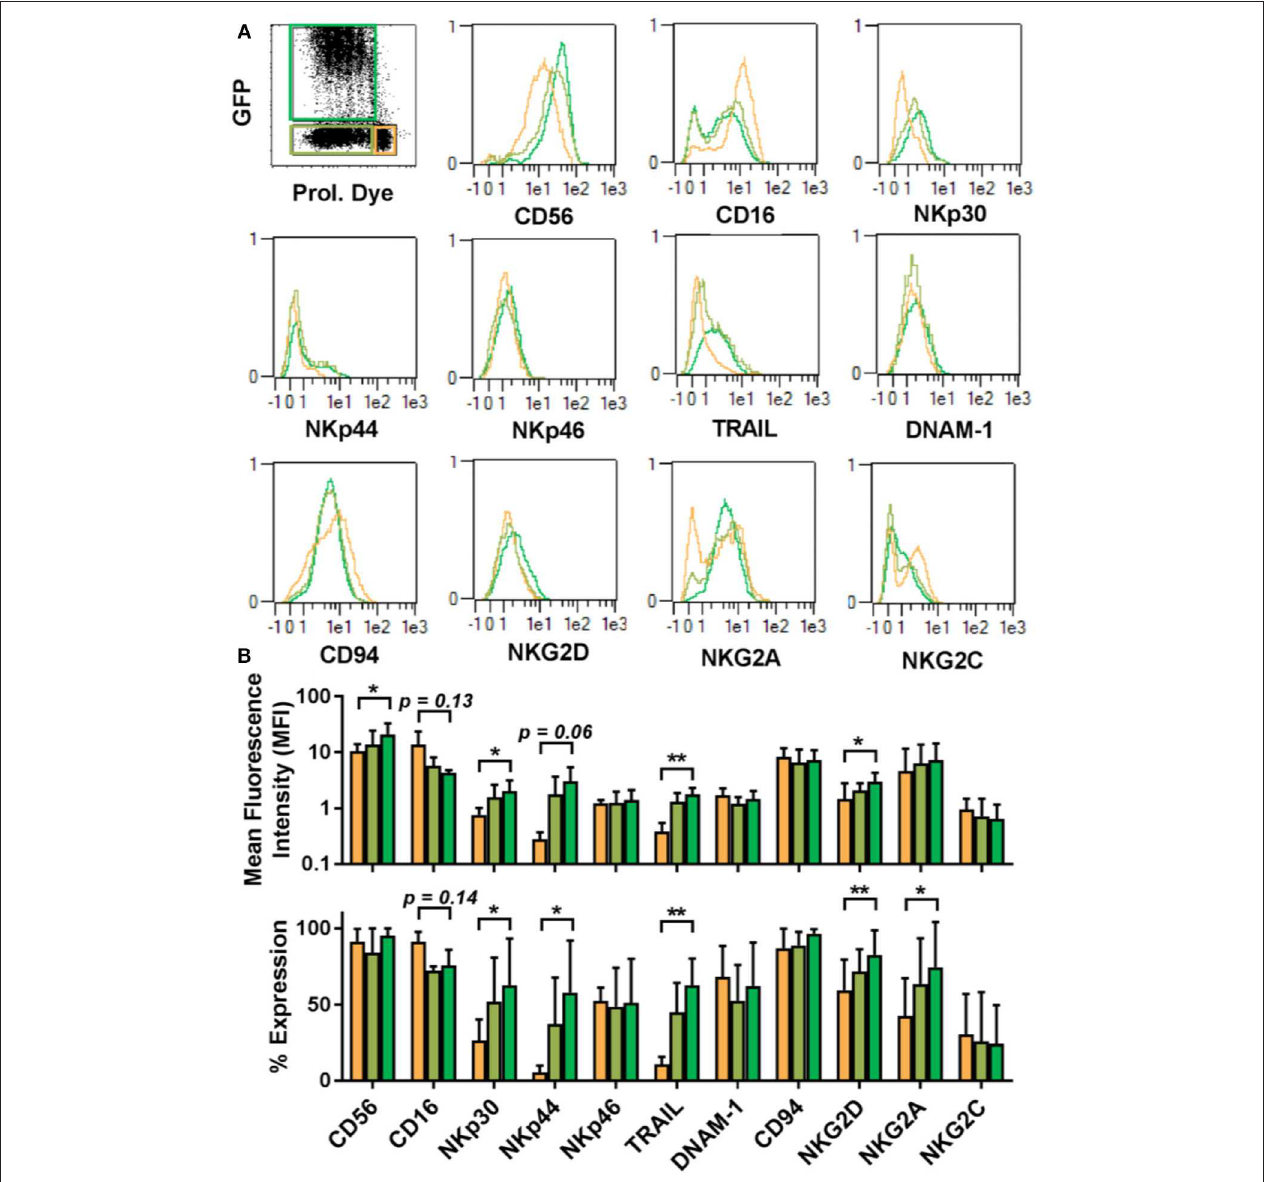
FIGURE 4 | Proliferative and quiescent NK cell subsets express different cell surface markers. Comparison of phenotype of several NK cell receptors among proliferated and transduced (green), proliferative but non-transduced (olive), and quiescent subsets of NK cells (orange) ( A , upper panel). Mean fluorescence intensity (MFI) and percentage of different receptors expression are shown in lower panel (B) . * P ≤ 0.05, ** P ≤